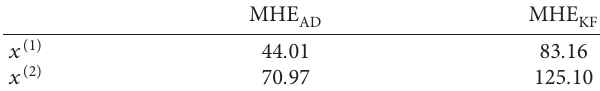
Table 1: Average sum square estimation error (example